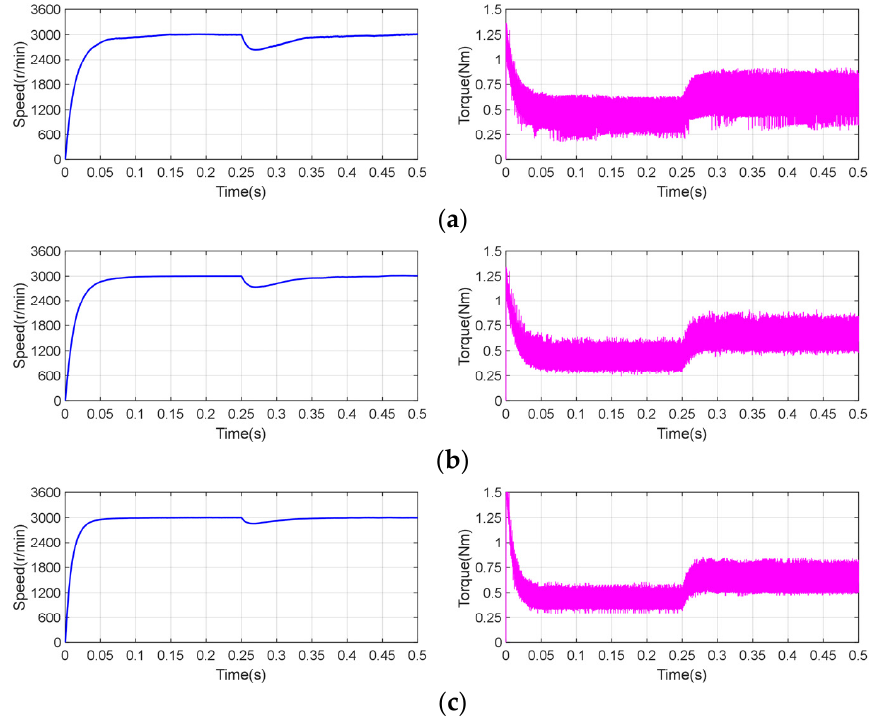
Figure 10. Experimental results under load torque change. ( a ) PI, ( b ) SMC, and ( c ) proposed TSMC.